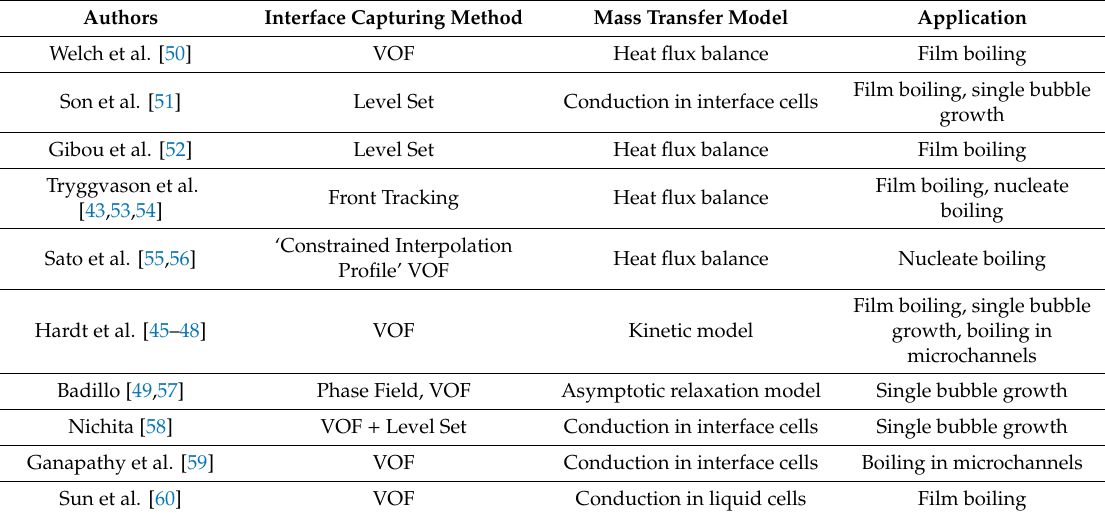
Table 1. Summative table of mass transfer models for boiling